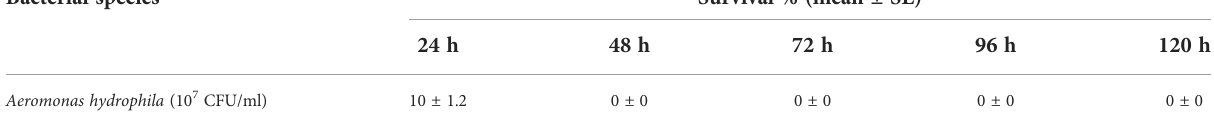
TABLE 2 Survival assay of Pangasianodon hypophthalmus challenged with Aeromonas hydrophila . Bacterial